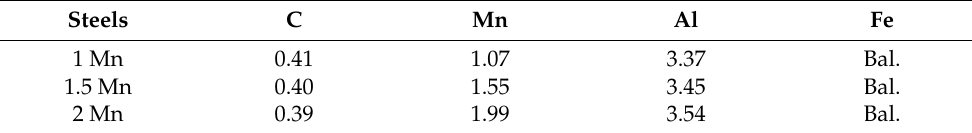
Table 1. Chemical compositions of three δ -TRIP steels with different Mn content (wt.%). Steels